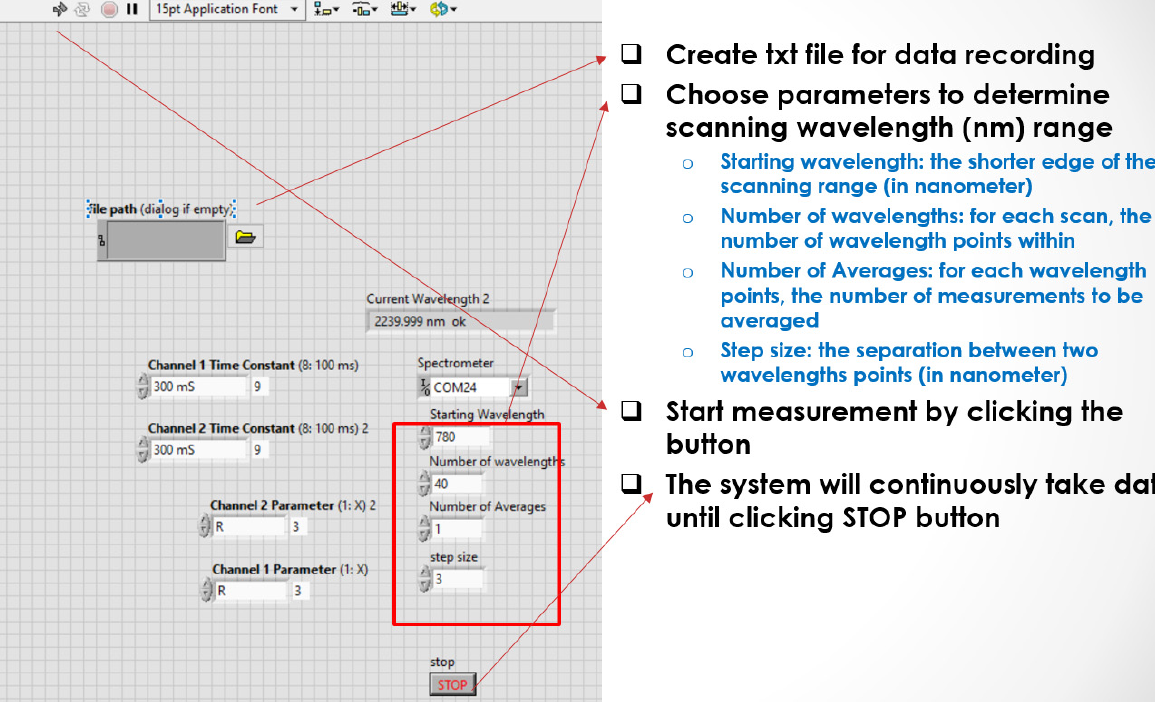
Figure 30. GUI input parameters for SCISCCO prototype.